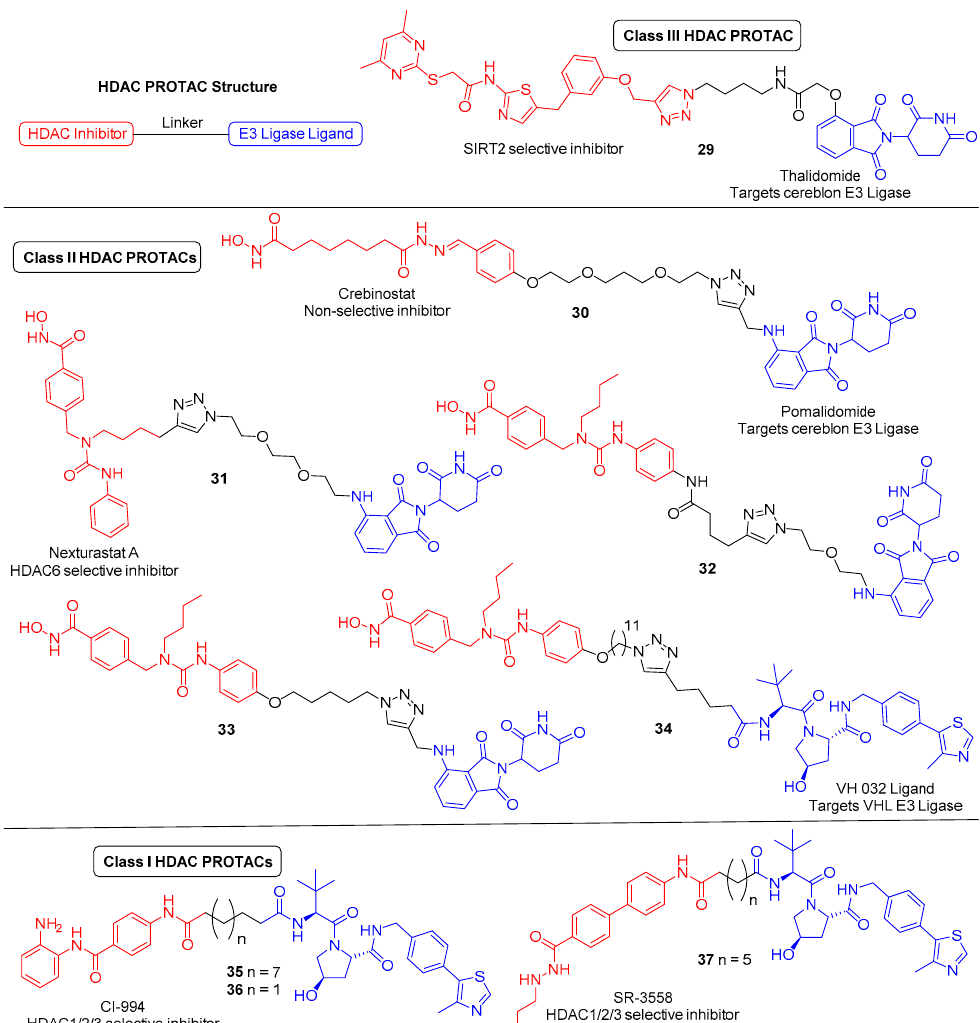
Figure 10. HDAC-targeting proteolysis-targeting chimeras (PROTACs). PROTAC components: HDAC inhibitor (red), small molecule E3 ligase ligand (blue), linker (black).